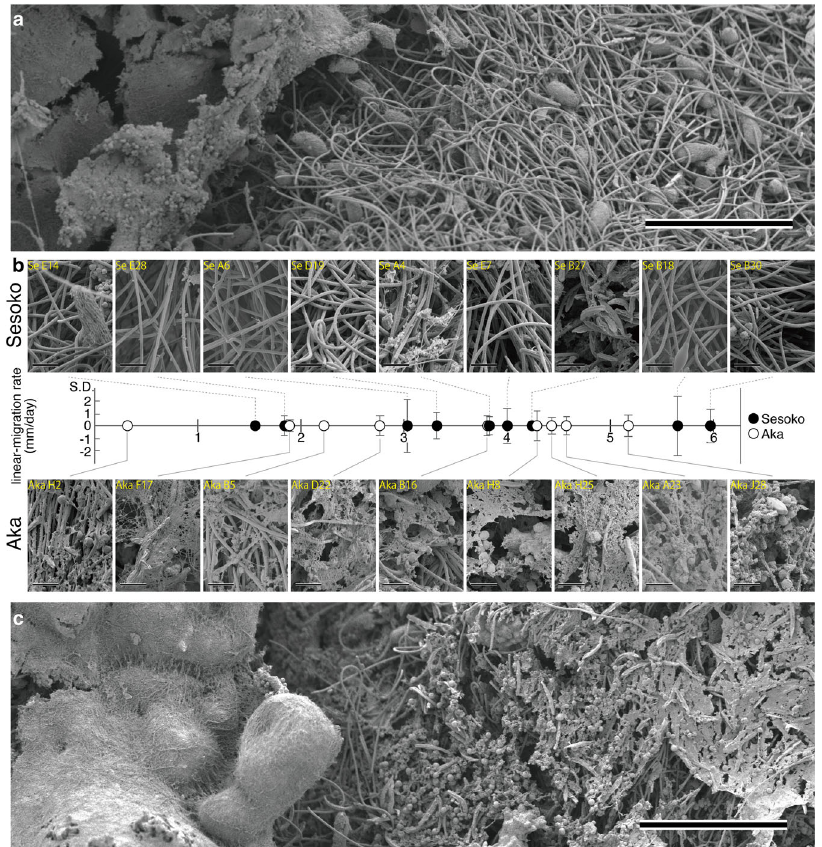
Fig. 2 SEM images displaying the surface structures of BBD from two locations with different migration rates. The sample from Sesoko Island ( a , upper parts in panel b ) displaying cyanobacterial fi laments with non-impurities on the surfaces than Aka Island. In Aka Island, the samples (lower parts in panel b and c ) showed extracellular polymeric substances (EPS) on the surfaces. Comparison of surface appearances between two locations across various migration rates ( b ). Scale bars indicate 200 µm ( a and c ) and 20 µm ( b ). The direction of BBD migration is from right to left ( a and c